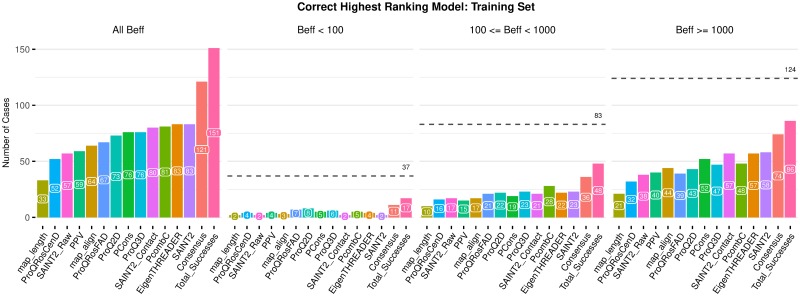
Number of targets out of the 244 targets in our Training set for which a correct model was produced and selected as the highest-ranked model according to 13 methods.Three SAINT2 scores (SAINT2, SAINT2_Contact and SAINT2_Raw), seven existing quality assessment scores (ProQ3D, ProQRosCenD, ProQRosFAD, Pcons, PcombC, ProQ2D and PPV), and three predicted contact map alignment scores (EigenTHREADER, Map_align and map_length) are shown, as well as all methods combined (“Consensus”) and the total number of targets with a correct model (“Total Successes”), for three Beff bins and across all bins. The total number of targets in each Beff bin is indicated with a dashed line.